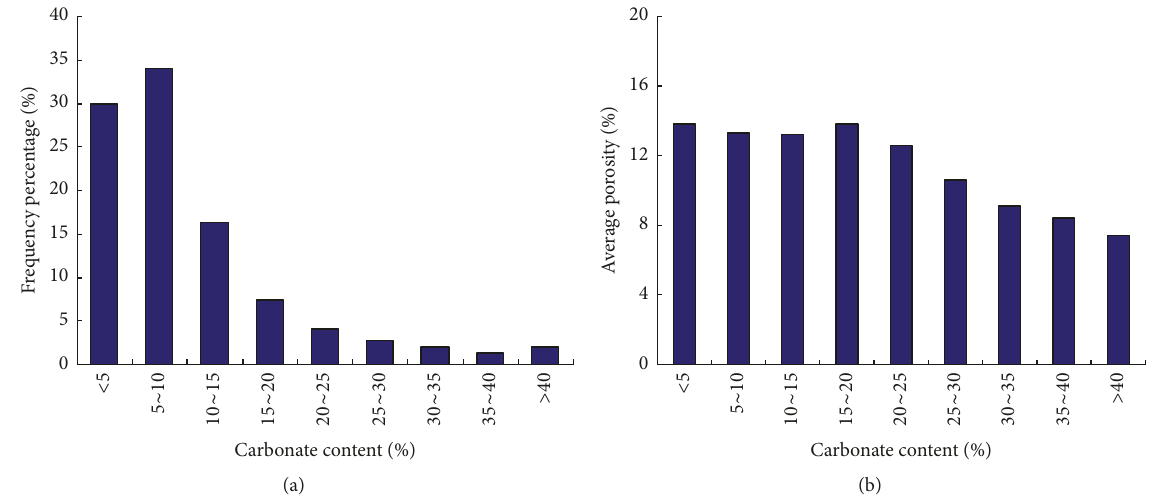
Figure 7: The distribution of carbonate content and its relationship with average porosity. (a) Carbonate content distribution histogram. (b) Carbonate content and average